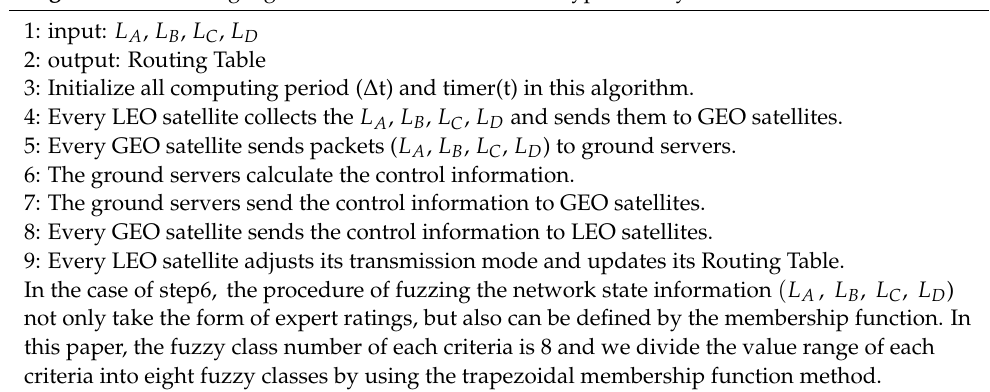
Algorithm 1. Routing algorithm based on the Interval type-2 fuzzy